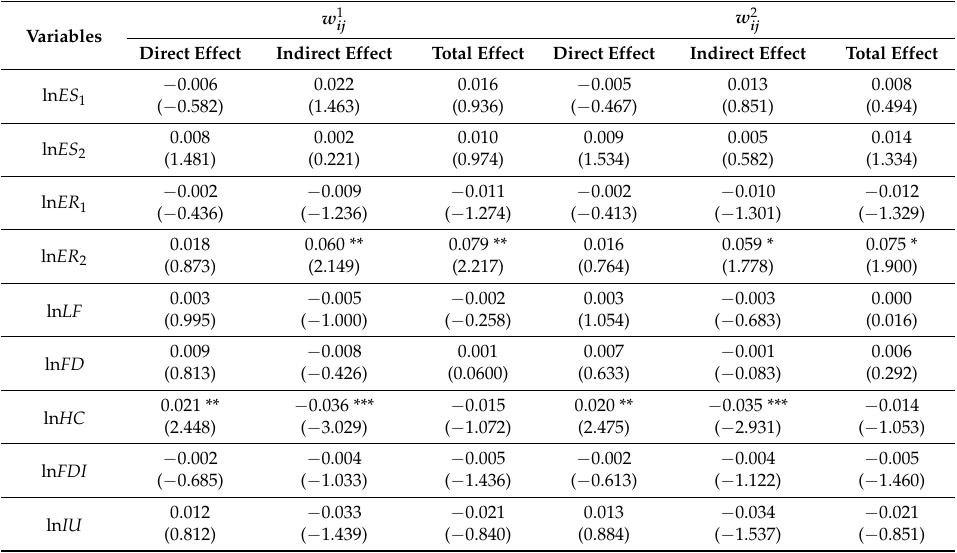
Table 8. The direct, indirect and total effects of the central region.